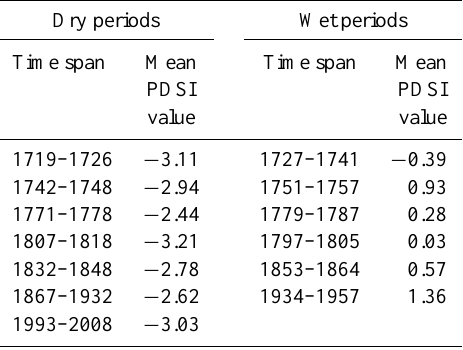
Table 2. Persistent dry and wet periods during